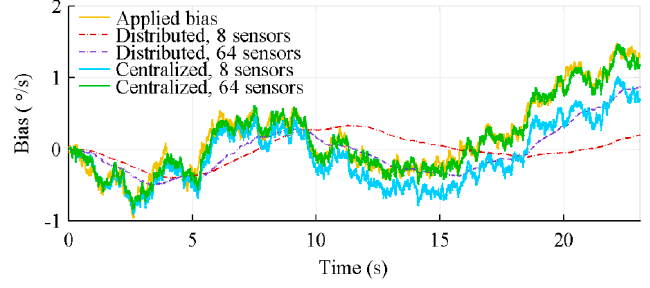
Figure 14. Bias estimation of gyroscopes measuring 𝑝, for 8 and 64 IMUs, with algorithms considering sensors location.